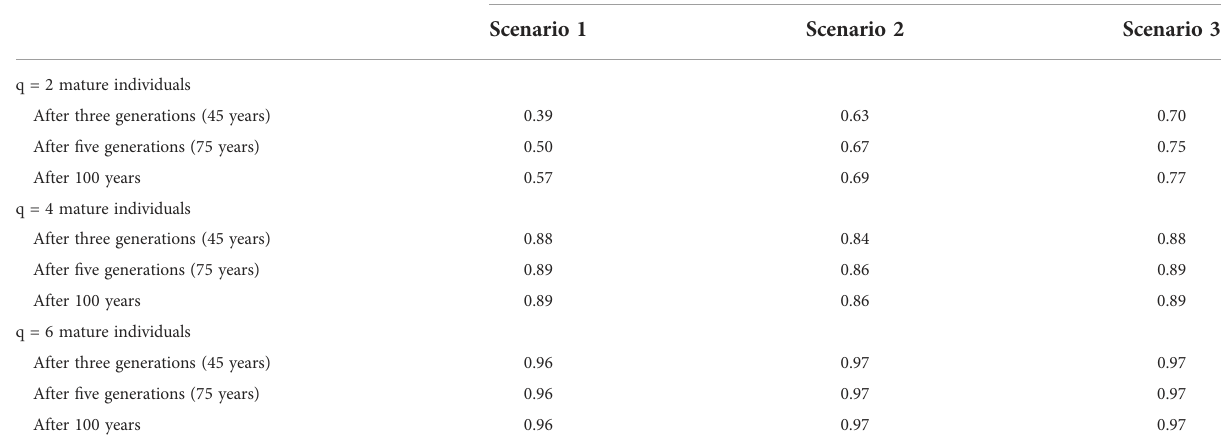
TABLE 7 Quasi-extinction probabilities.